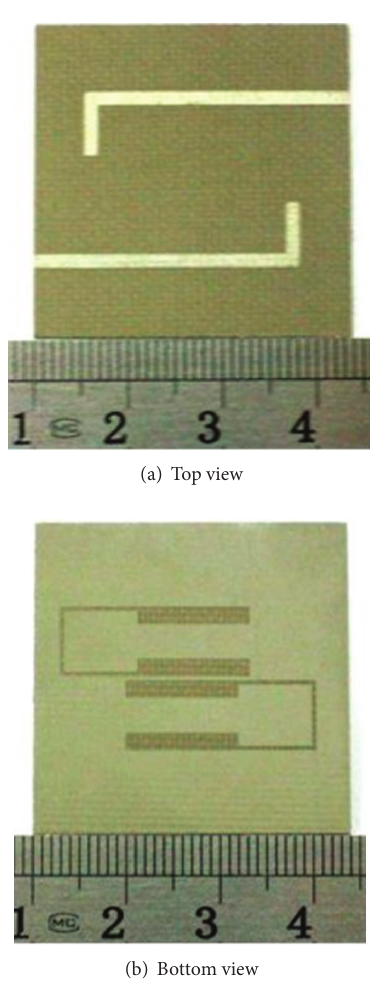
Figure 5: Photograph of the proposed filter. (a) Top view and (b) bottom view.